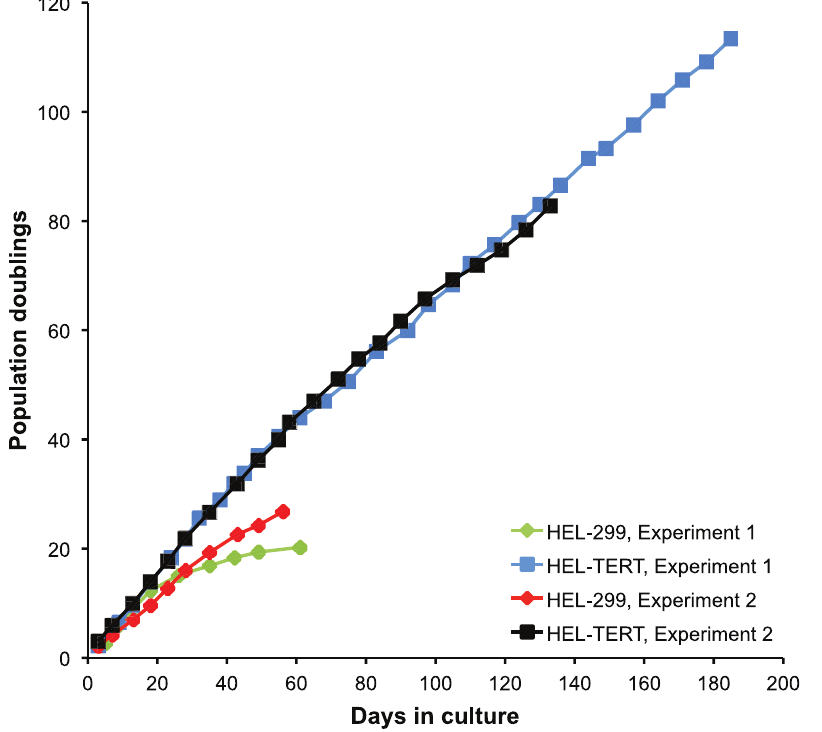
Figure 1. HEL-TERT cells are life-extended compared to HEL-299 cells. HEL-TERT and HEL-299 cells were plated as duplicate cultures in 60 mm dishes at 1 6 10 5 and 2 6 10 5 cells per plate, respectively. For each passaging, cells were counted and re-plated. Population doublings were determined by using cell counts and days in culture.